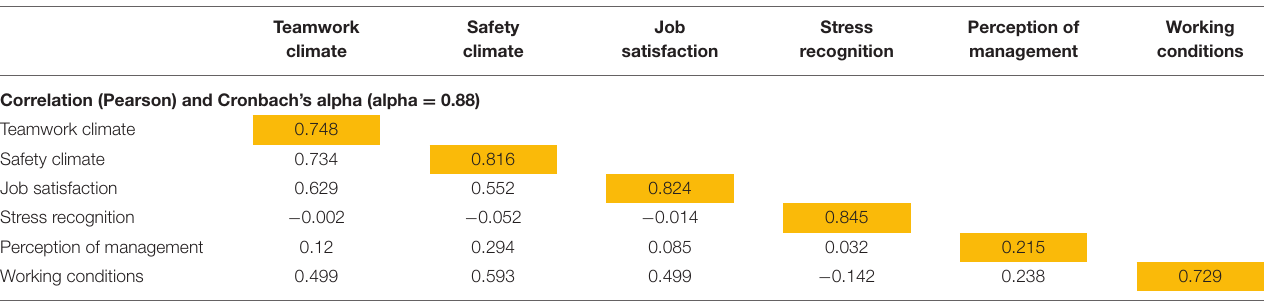
TABLE 3 | SAQ factors correlations and Cronbach’s alpha.